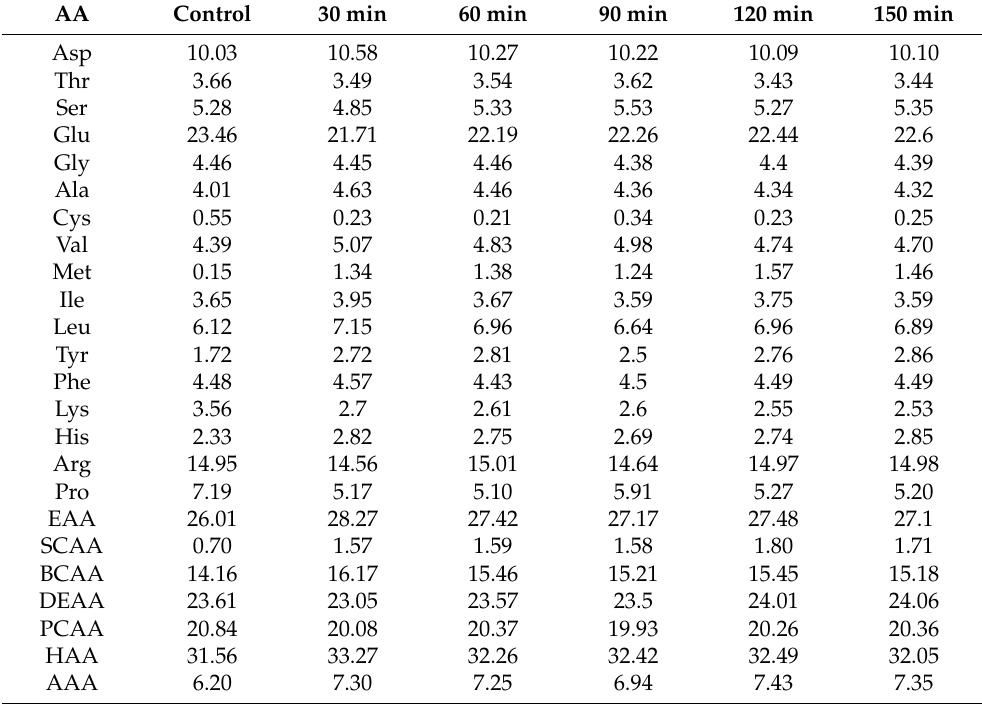
Table 3. Amino acid composition (%) of WPHs * at different hydrolysis